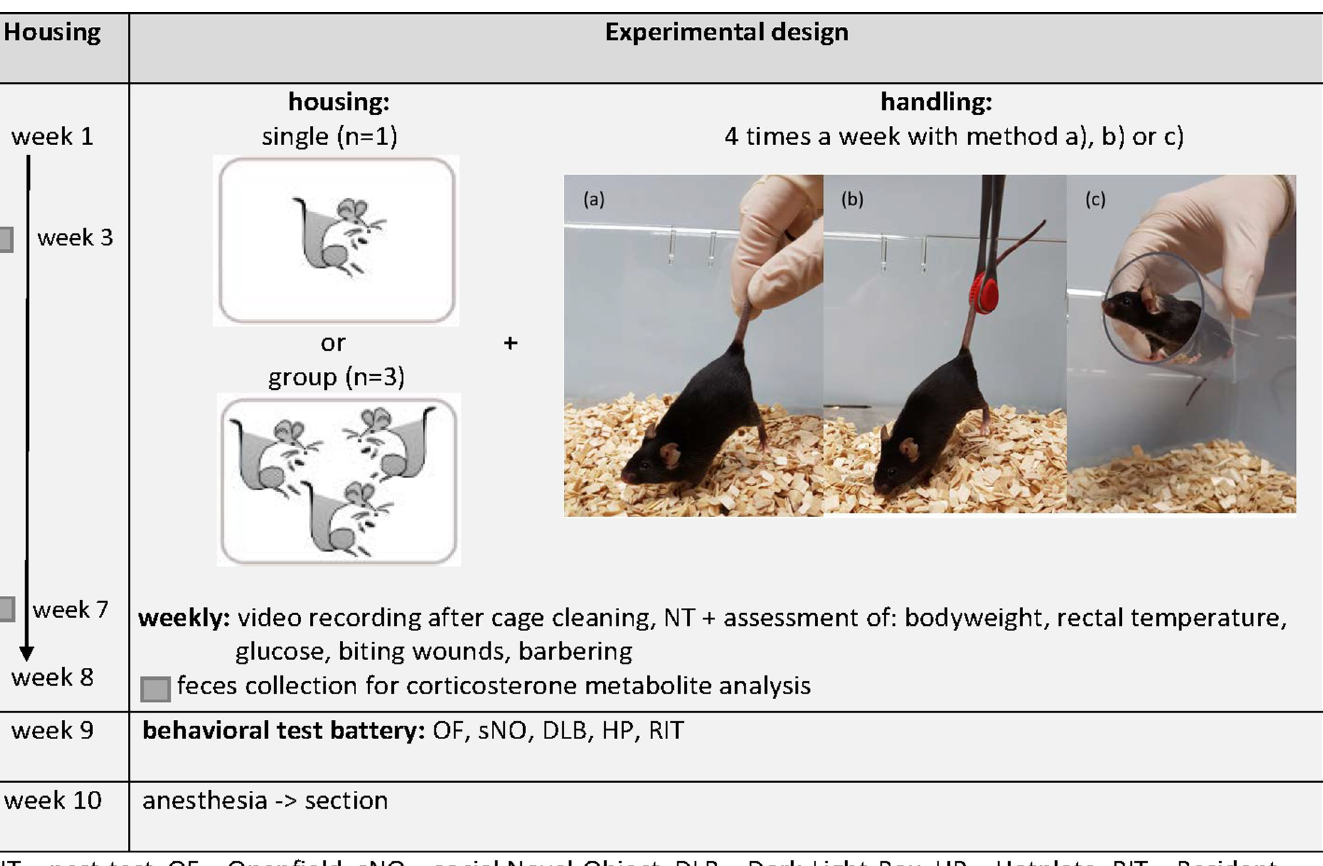
Fig 1. Experimental design. Overview of the procedures for single- and group-housed cohorts: (a) = tail; (b) = forceps; (c) = tube. Behavioral analysis (except the NT) of mice started at week 9 and lasted until the animals were euthanized at 10 weeks.